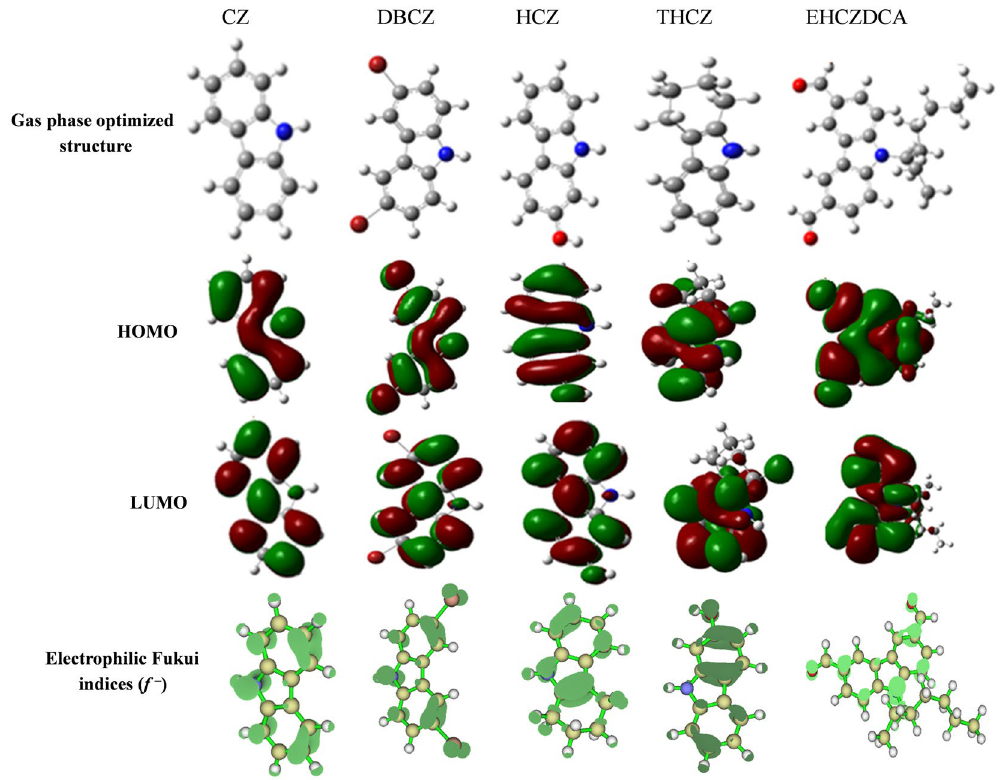
Figure 9. Optimized structure, HOMO, LUMO and the electrophilic Fukui function ( f − , isosurface value = 0.003) for neutral molecules of the studied compounds in the gas